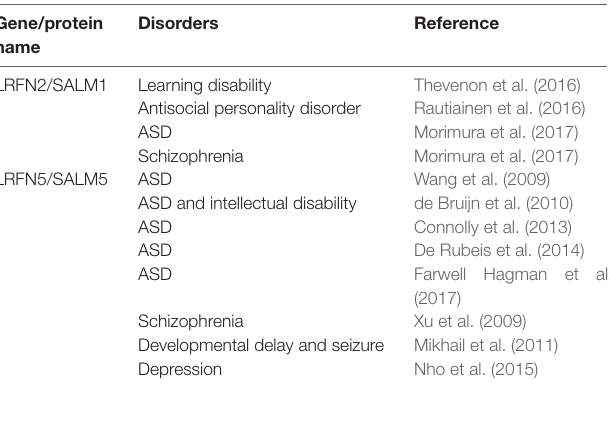
TABLE 3 | Associations of SALMs/LRFNs with neurodevelopmental and psychiatric